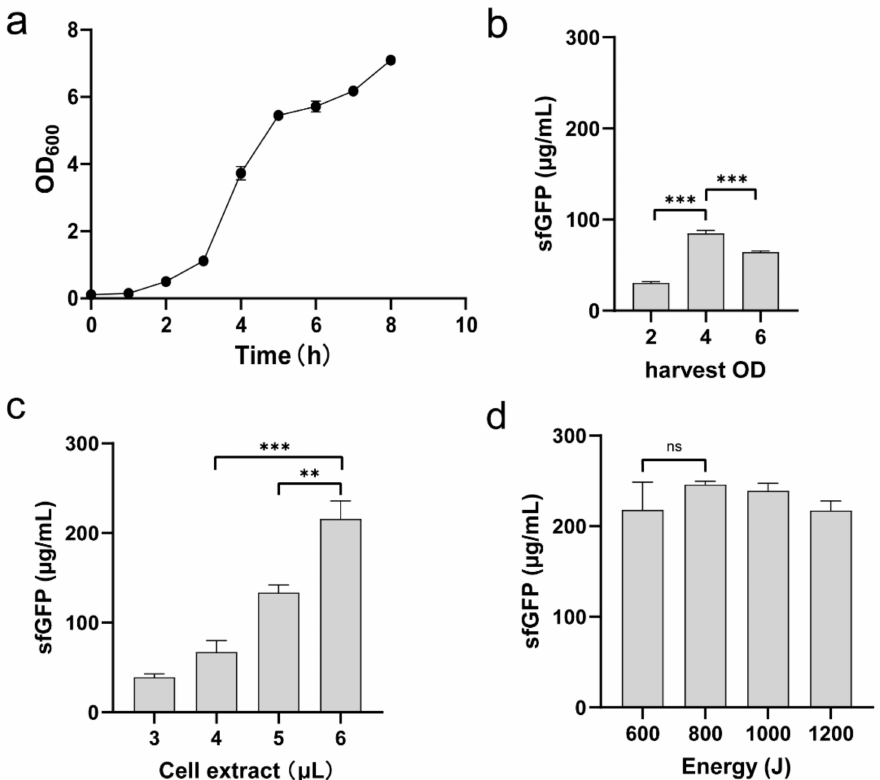
Figure 3. Optimization of cell extract preparation. ( a ) A representative cell growth curve of the strain KP_1.6366 ∆ wzy . ( b ) Comparison of sfGFP yields with ∆ wzy cell biomass harvested at different optical densities (OD 600 ). ( c ) Evaluation of cell extract volume on cell-free synthesis of sfGFP. ( d ) Effect of sonication energy on the activity of cell extracts. Values show means with error bars representing standard deviations (s.d.) of at least 3 independent experiments. Student’s t -tests were used for statistical analysis, and p < 0.05 indicated statistical significance (** p < 0.01 and *** p < 0.001; ns, p >